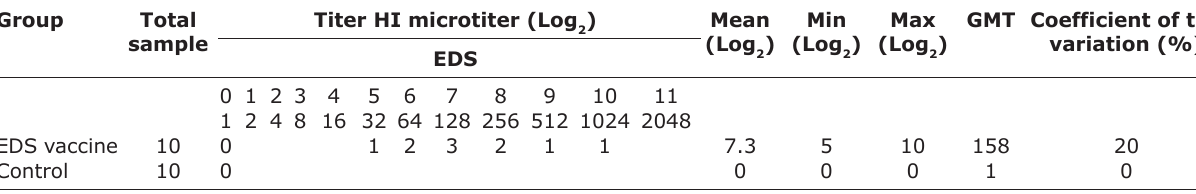
Table-1: Antibody titer of SPF chickens post-vaccination of EDS seed vaccine. Group Total sample